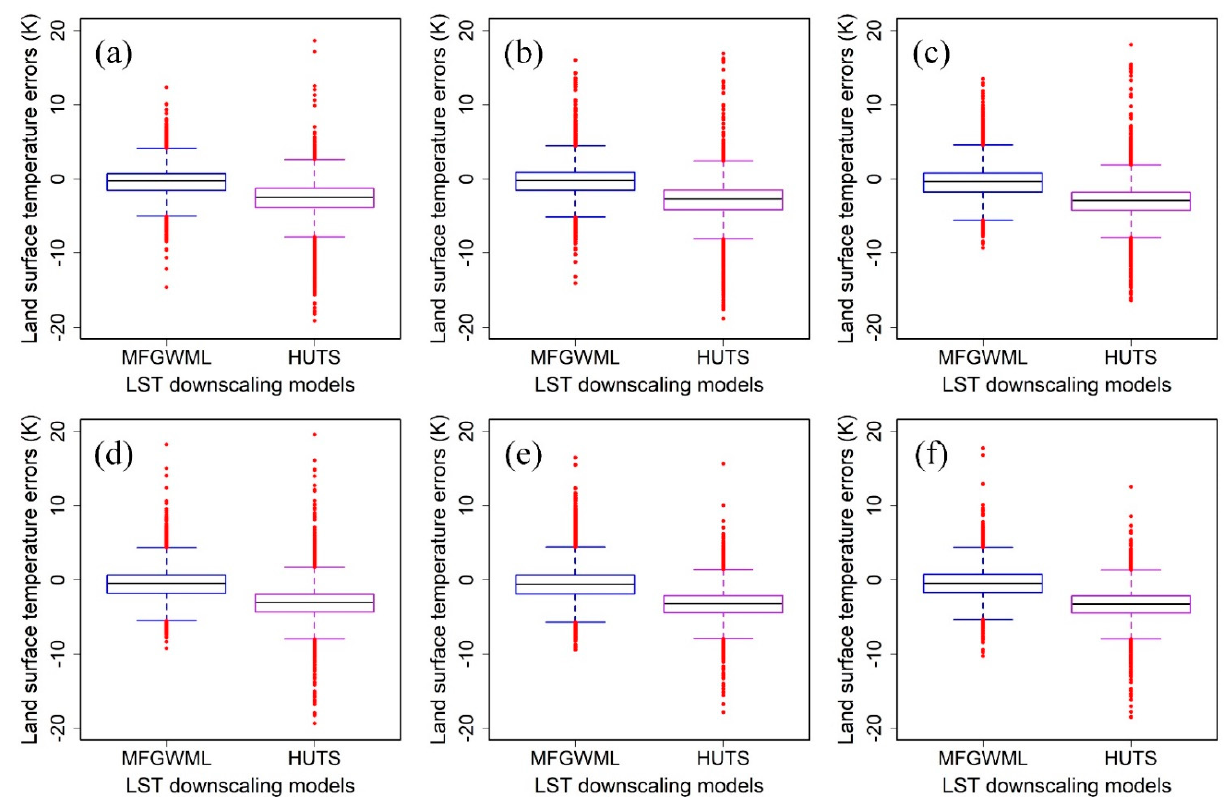
Figure 14. LST error distribution boxplots of the MFGWML and HUTS models for the six downscaling schemes: ( a ) Scheme 1, ( b ) Scheme 2, ( c ) Scheme 3, ( d ) Scheme 4, ( e ) Scheme 5, and ( f ) Scheme 6. The black line indicates the median value. The blue and purple boxes indicate the percentiles for the MFGWML and HUTS models, respectively. The solid red dots indicate outliers. Table 11. Statistical indicators of LST error distribution in MFGWML and HUTS for six downscaling schemes performed around the central urban area.